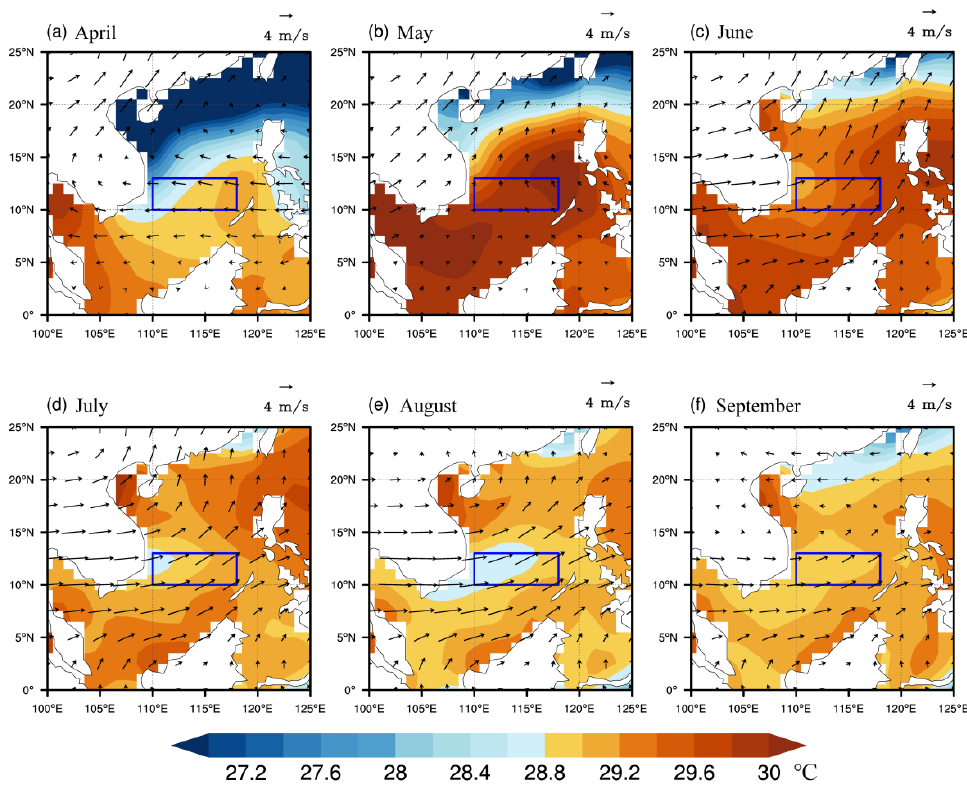
Figure 1. Climatological monthly mean South China Sea SST (°C) and winds (m/s) at 850 hPa in ( a ) April, ( b ) May, ( c ) June, ( d ) July, ( e ) August, and ( f ) September for the period 1970–2018. The blue rectangle denotes the CT region.